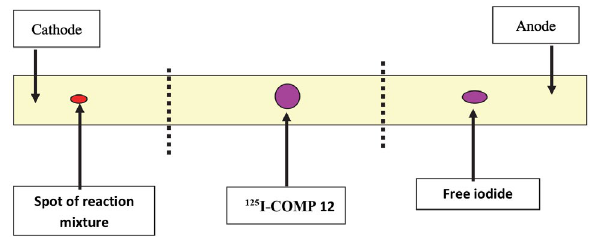
Figure 1: Paper electrophoresis for 125 I- TP 5 and free